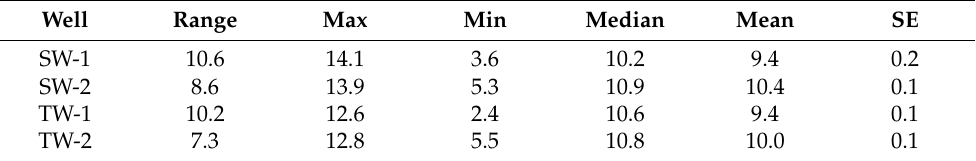
Table 3. Mean, minimum (min), standard error (SE), median, and maximum (max) subsurface flow temperature ( ◦ C) levels for the wells in the stream (SW-1 and SW-2) and intermittent tributary (TW-1 and TW-2) from 1 May 2016 to 30 April 2017. Well